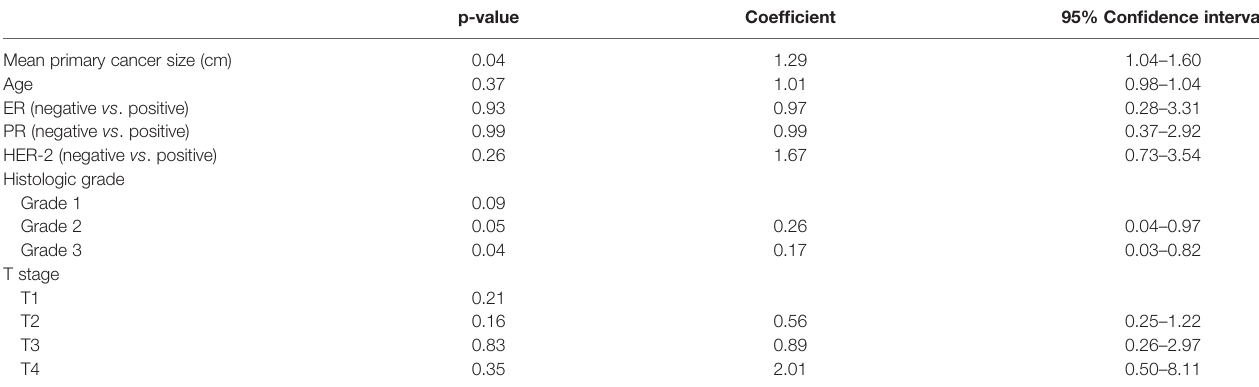
TABLE 7 | Multivariate analysis of the factors affecting the true-positive/true-negative versus false-positive/false-negative results of axillary